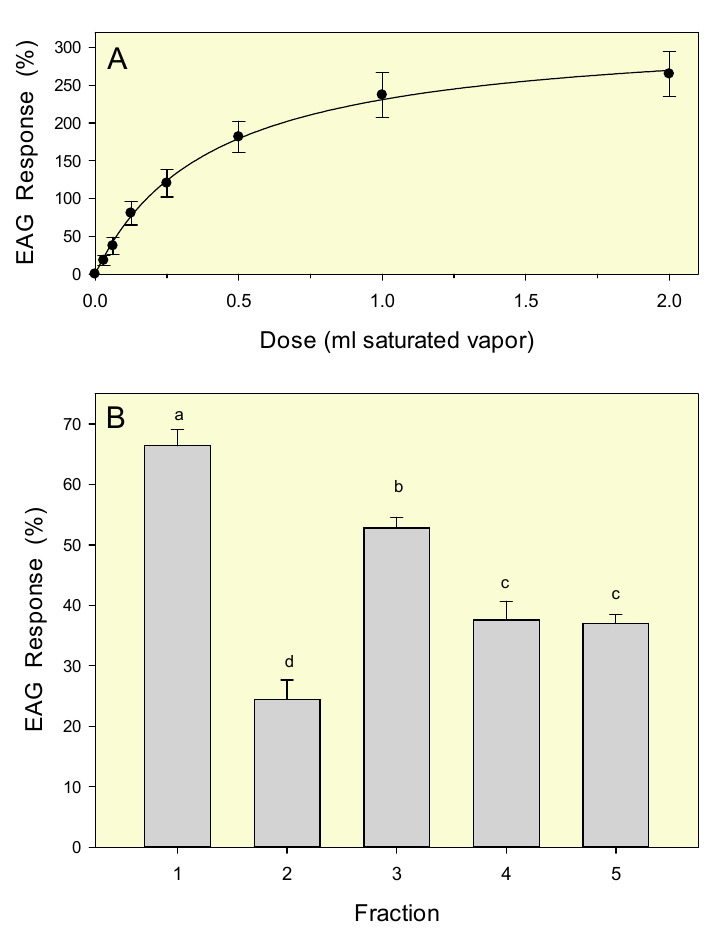
Figure 6. Mean ( ± SEM) electroantennogram responses of male C. capitata to volatiles emitted from TTO. ( A ) Dose-response curve obtained with a series of volumetric doses of volatiles from whole oil; curve generated with a hyperbolic regression model (see text). ( B ) Comparative electroantennogram responses (mean ± SEM) to fixed 1 mL doses of volatiles emitted from the five TTO fractions. All responses are expressed as normalized percentages relative to a standard reference compound (2-butanone, 100 µ L saturated vapor). Bars topped with the same letter are not significantly di ff erent (Tukey HSD mean separation, p < 0.05).